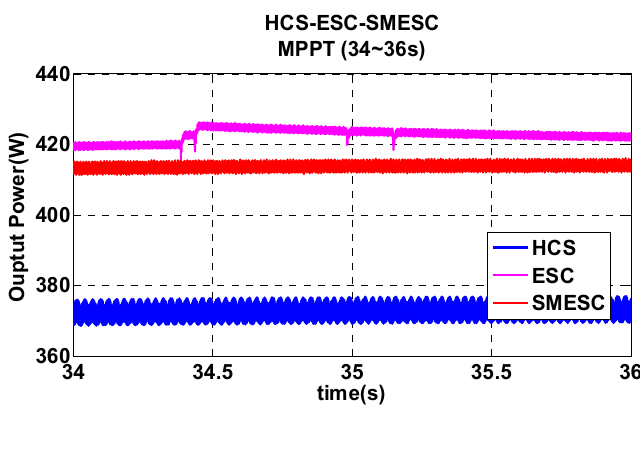
Figure 19. Output dynamic response of HCS, ESC and SMESC algorithms respectively (variable wind speed, 10.5–12.5 m/s) (34–36